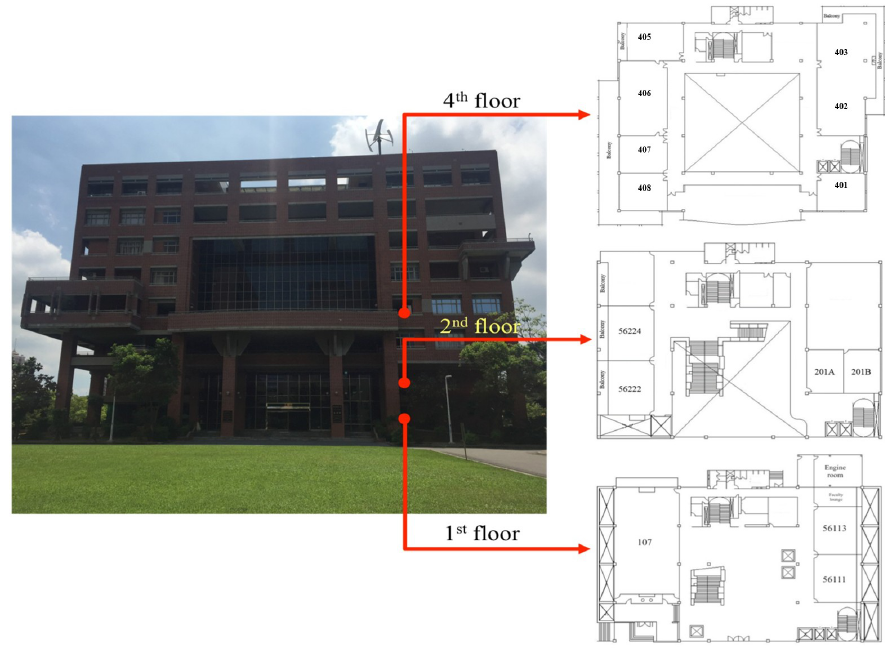
Figure 12. The test building and the layouts of floors for this proposed estimation